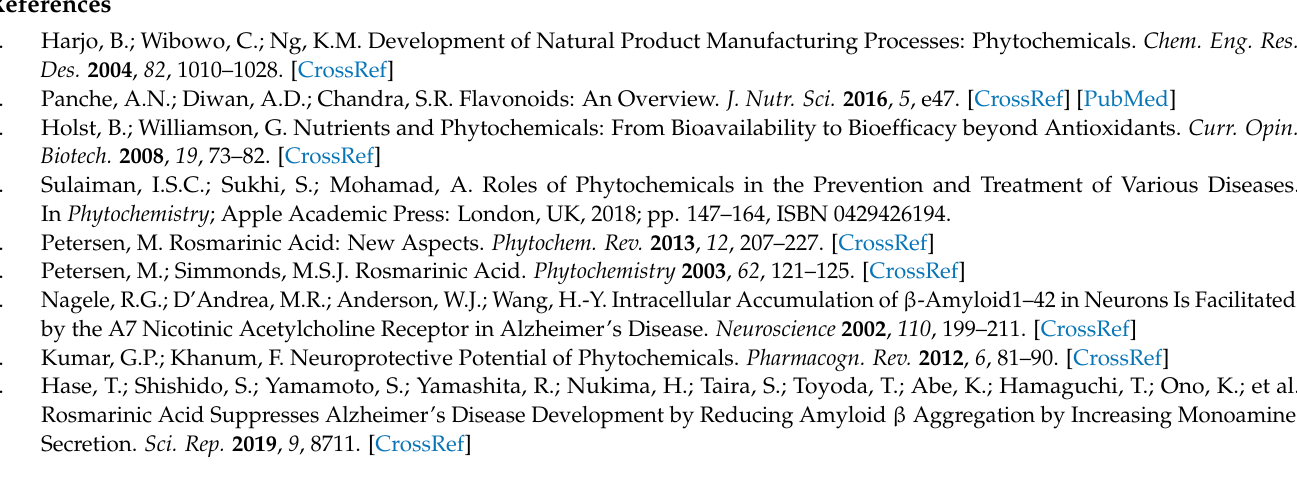
Figure S2: DLS size distribution of unloaded PLGA NPs; Figure S3: DLS size distibutions of RA-loaded PLGA NPs; Figure S4: Dark-field microscopy studies; Figure S5: Calibration curve of RA; Figure S6: Fitted curve release kinetic models; Figure S7: PLGA_PC images; Figure S8: DLS size distributions of PLGA_PC and RA-loaded PLGA_PC; Figure S9: Calibration curve of a model protein; Figure S10: PLGA NPs images in the absence of 10%FBS; Figure S11: In vitro scavenging effect of free RA and EC50 estimation; Figure S12: DLS size distribution of fluorescently labelled polymeric NPs; Table S1: HPLC conditions; Table S2: Drug release